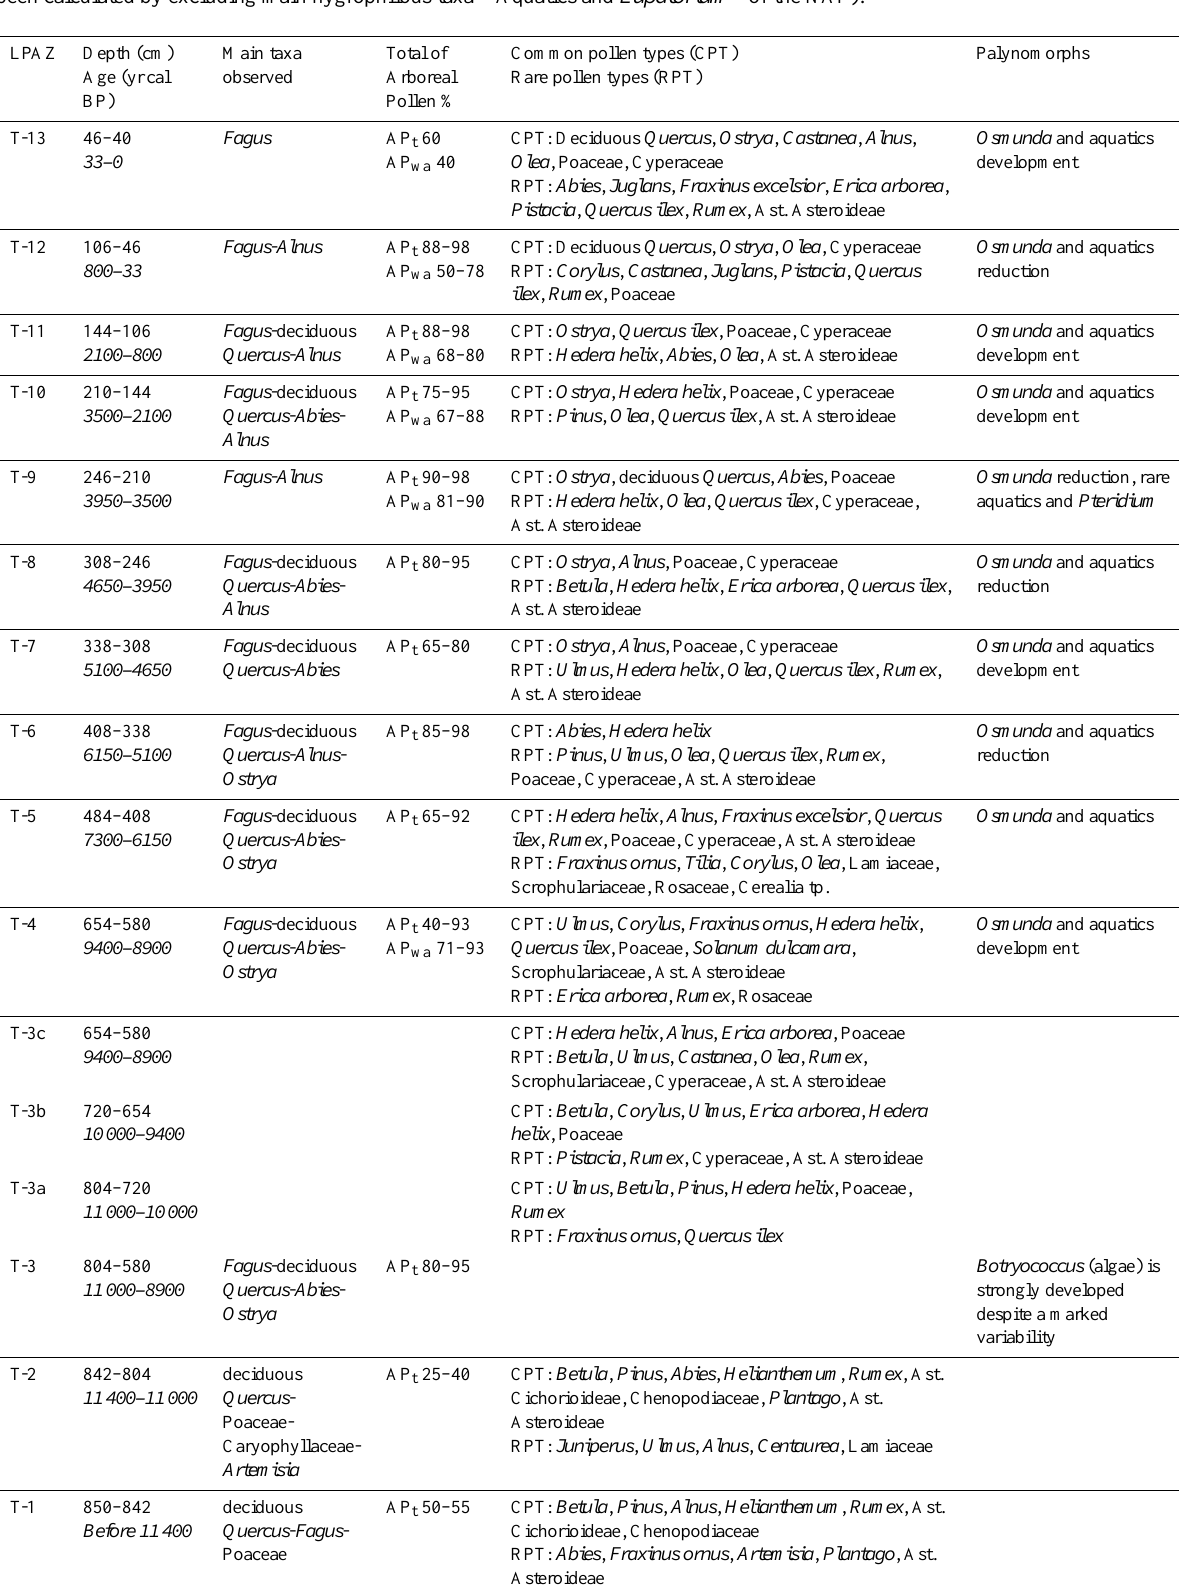
Table 3. Inventory of local pollen zones with depth and estimated ages, main taxa, total of arboreal pollen (AP), common and rare pollen types and palynomorphs used for hygrophilous vegetation. Note that two ratios AP t and AP wa are used (arboreal pollen without Alnus (AP wa ) has been calculated by excluding main hygrophilous taxa – Aquatics and Eupatorium – of the